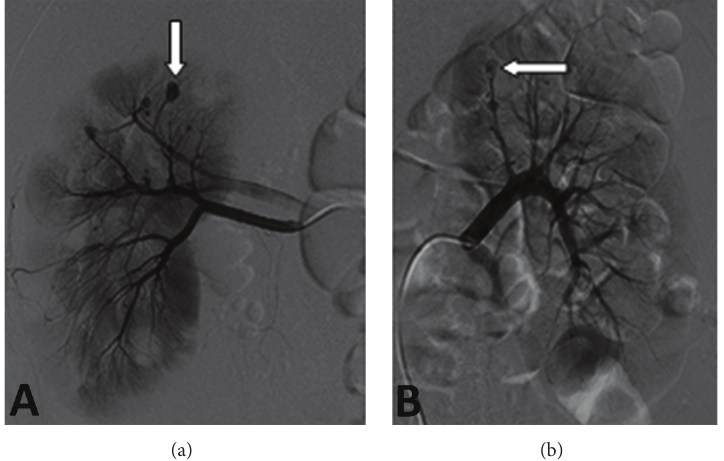
Figure 2: Angiographic studies of the vasculature of the right kidney, left kidney. An angiogram of the vasculature of the right kidney (a) reveals multiple small aneurysms; an angiogram of the vasculature of the left kidney (b) shows many small